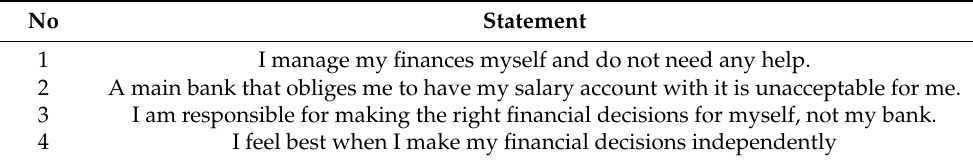
Table 2. Statements used for need “autonomy”.